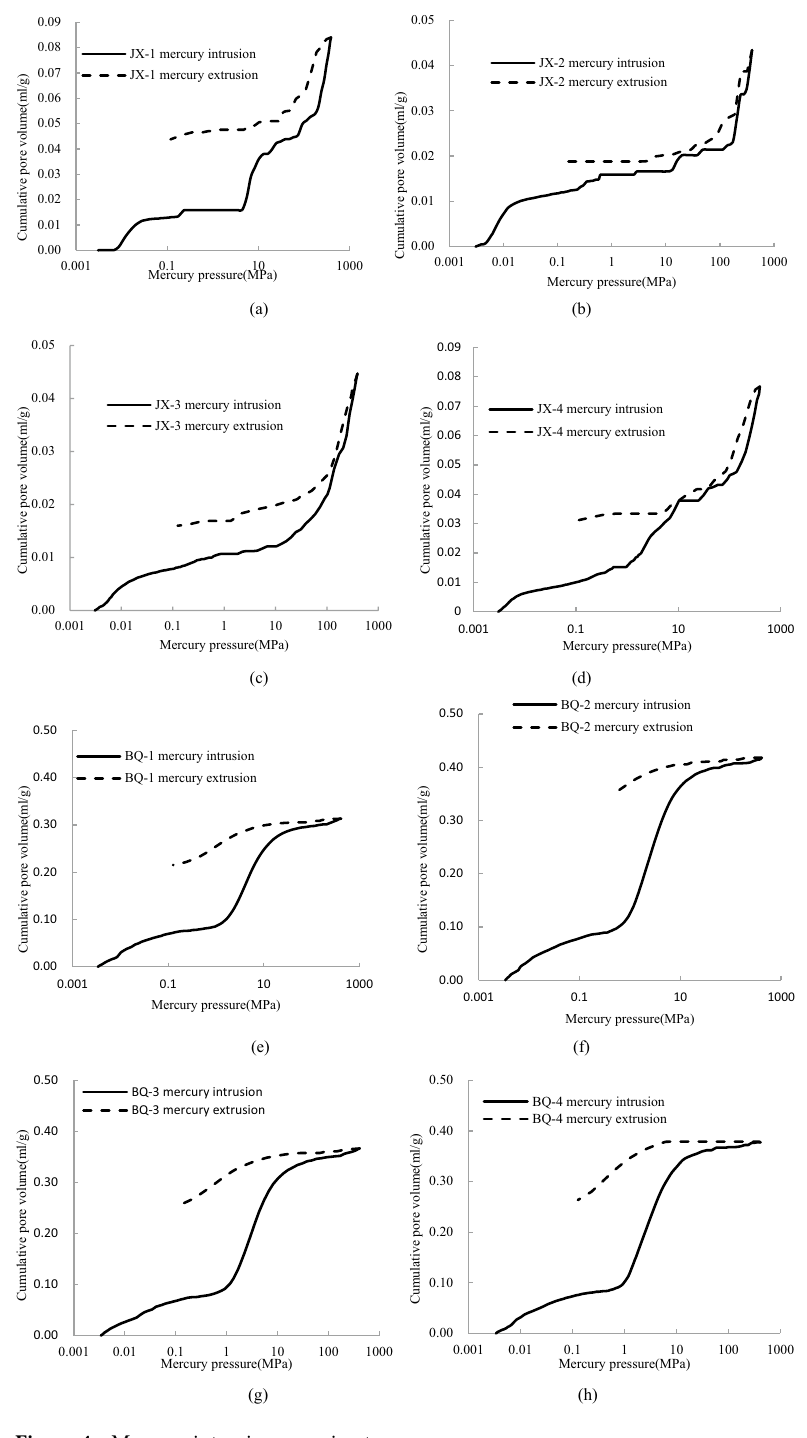
Figure 4. Mercury intrusion porosimetry